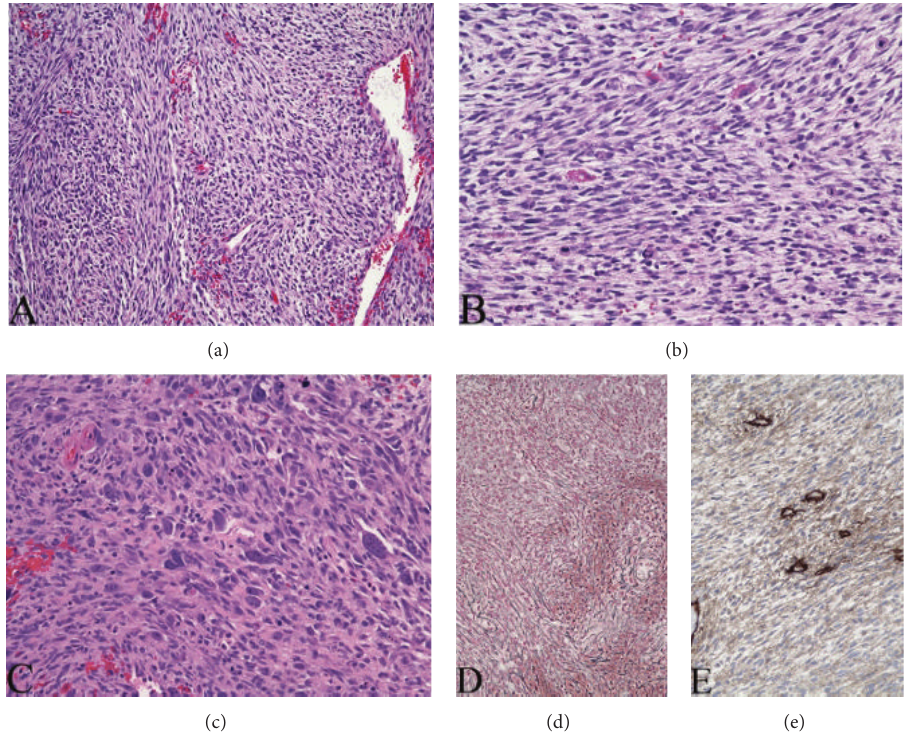
Figure 3: Resection of tumor recurrence showing frank sarcoma composed of intersecting fascicles spindle cells (a), often in a loose arrangements (b), or showing epithelioid changes (c). Granular cytoplasmic changes were evidence (b). Tumor cells are enmeshed by reticulin (d) and collagen IV-containing basal laminas (e). Original magnifications: 100x (a), 200x